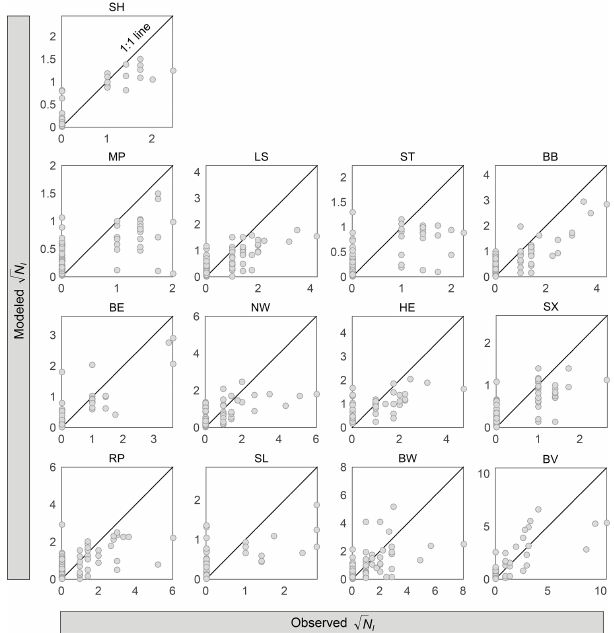
Figure 11. RF predictions for different regions in Germany (trans- formed